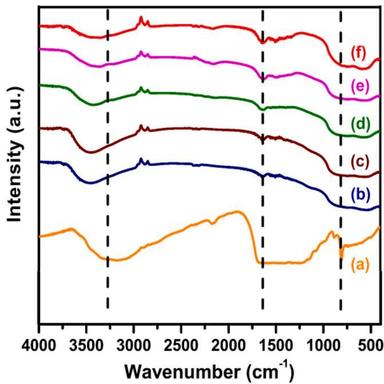
IR spectra of g-C3N4, CN-A and Al2O3 samples with various loadings: (a) g-C3N4; (b) Al2O3; (c) 4.7CN-A; (d) 9CN-A; (e) 13CN-A; (f) 16CN-A.